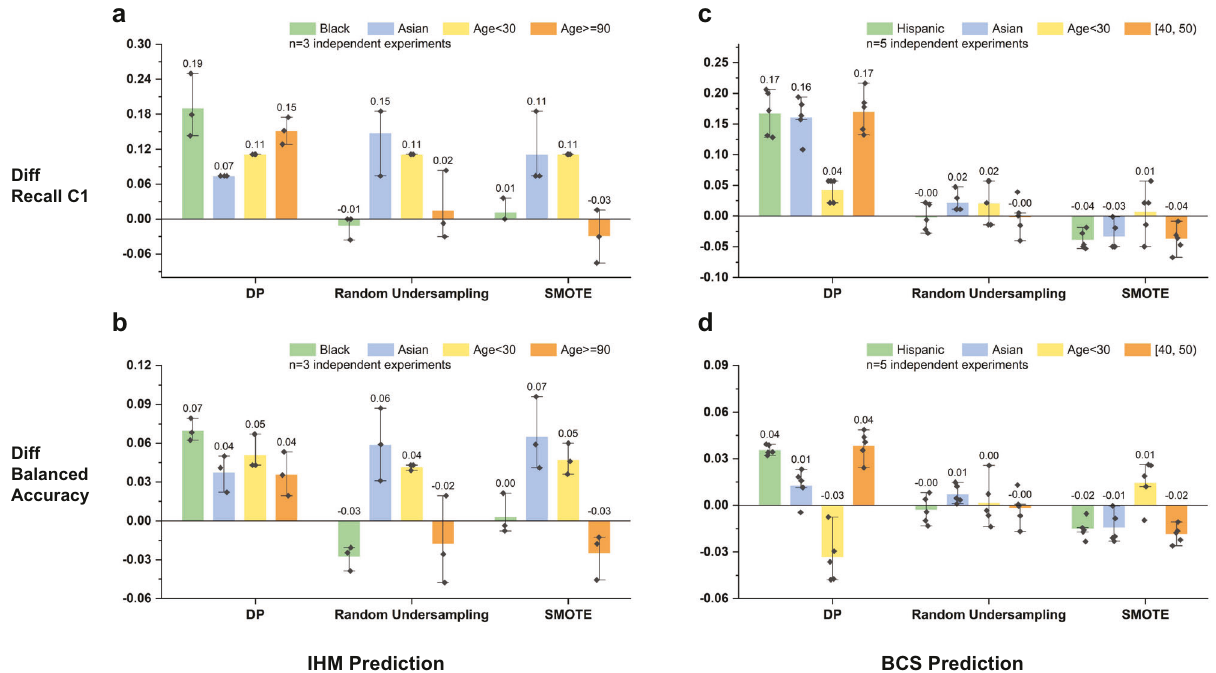
Fig. 6 Performance comparison of DP and two representative sampling techniques (namely, random undersampling and SMOTE) over the original model for four demographic subgroups with poor original performance. Positive values indicate performance improvement, and negative values indicate performance degradation from the original model. The error bars represent the standard error of the experiment results. Performance comparison ( a ) in terms of recall C1 for IHM prediction with the MIMIC III dataset, b in terms of balanced accuracy for IHM prediction with the MIMIC III dataset, c in terms of recall C1 for the BCS prediction with the SEER dataset, d in terms of balanced accuracy for the BCS prediction with the SEER dataset.